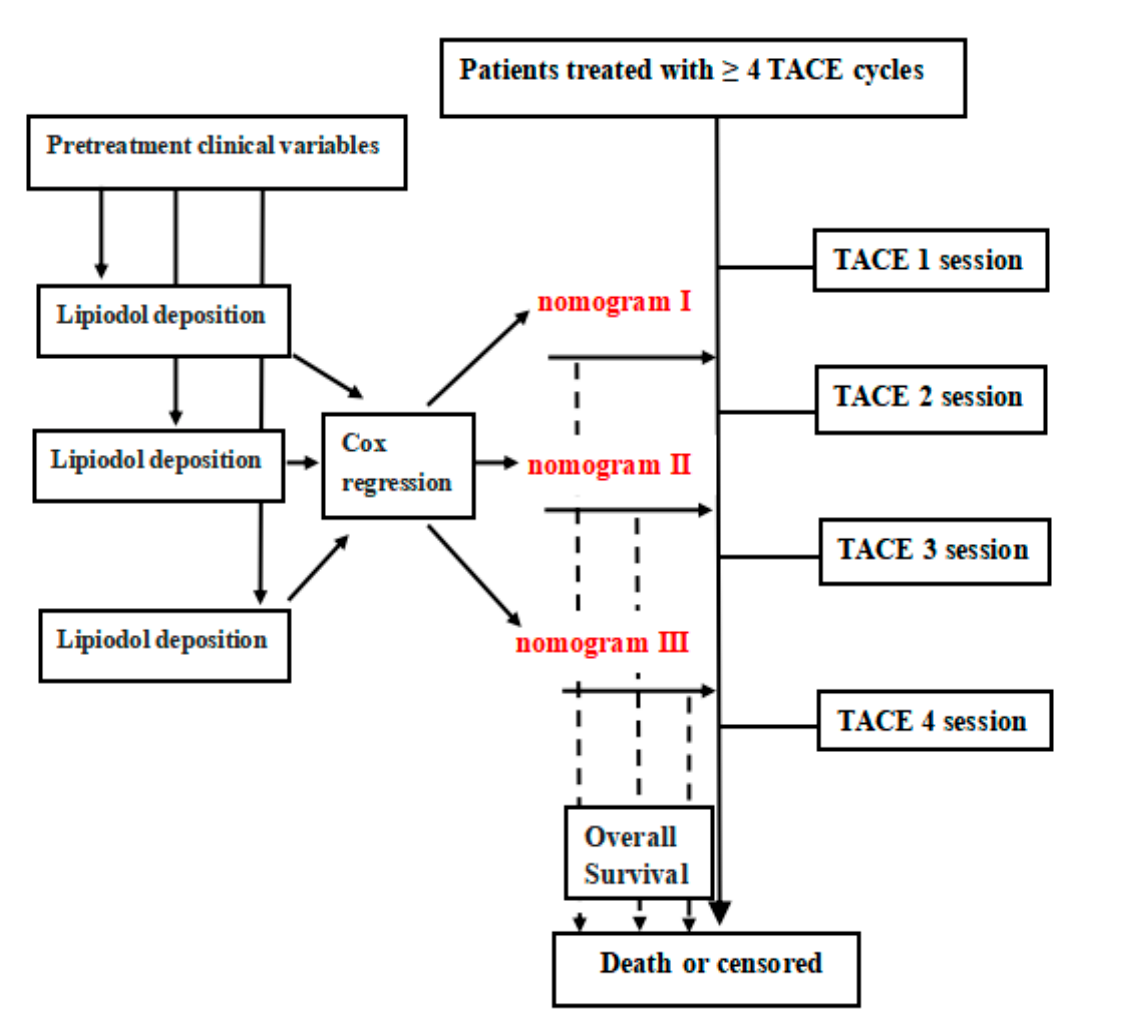
Figure 3. Study design for nomogram construction. Nomograms were built by Cox regression anal ‐ yses based on each pretreatment lipiodol deposition and clinical variables. TACE: transarterial che ‐ moembolization.